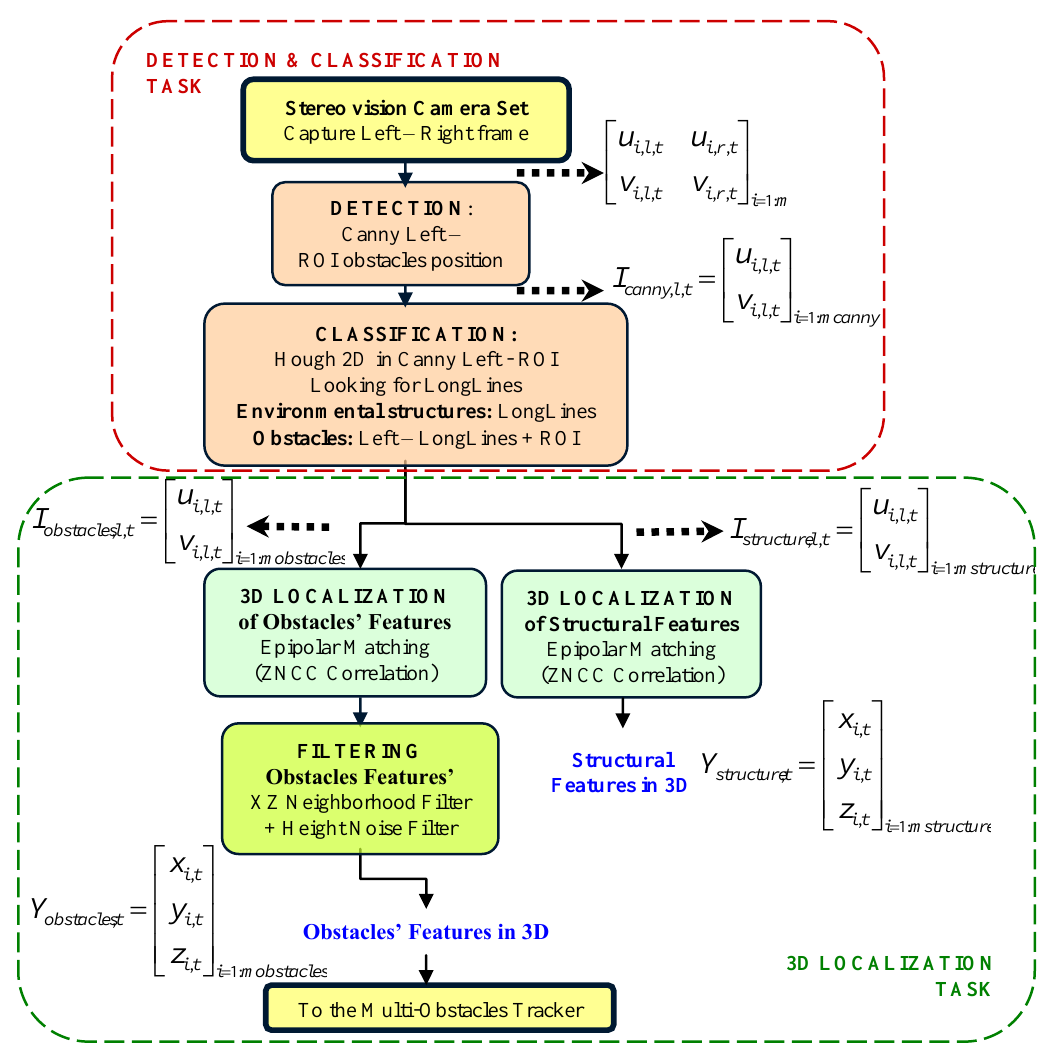
Figure 4. Flowchart of the data acquisition subsystem, based on a stereo vision process. Main tasks are: detection and classification (blocks at the top); and 3D localization (blocks at the bottom). Inner structure of each main task is highlighted and